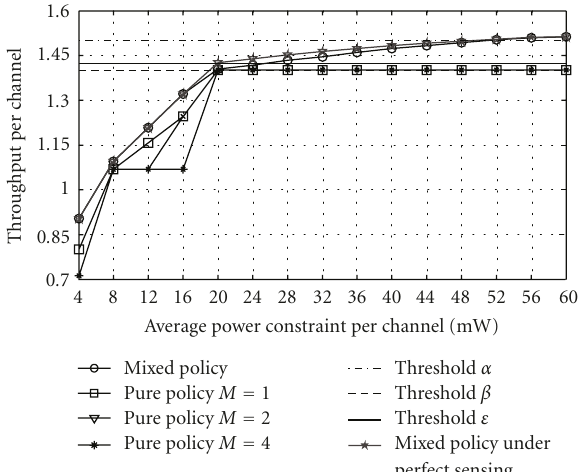
Figure 4: Performance comparison of decentralized optimal mixed policies and pure policies under di ff erent average power constraints.